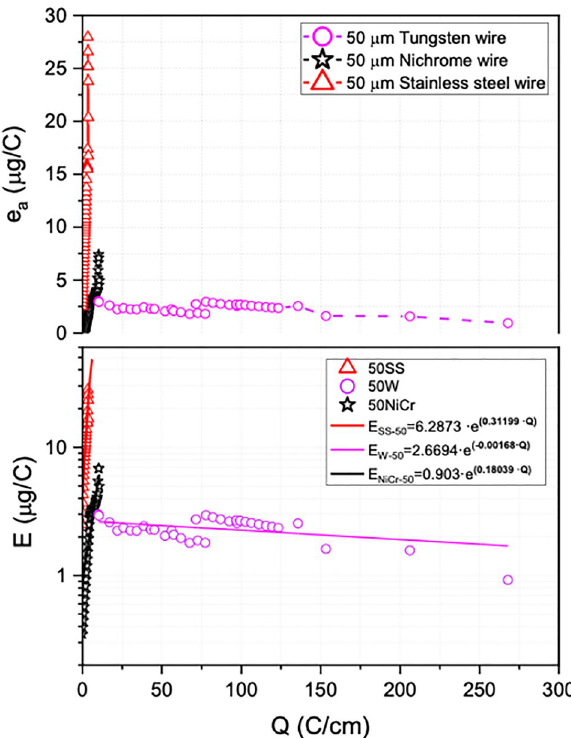
Figure 3. Analysis of tungsten, nichrome and stainless steel as corona electrodes relating average erosion rate (e a ) and erosion rate (E) depending on transferred charge. All corona electrode assays are shown in Table